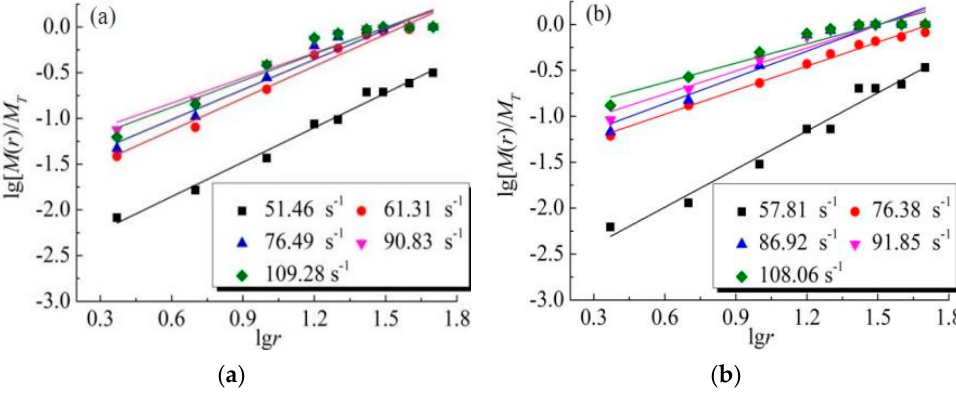
Figure 12. lg[ M ( r )/ M T ]-lg r linear fitting curve ( a ) PC; ( b ) CNFC02. The data points in Figure 12 show good linear correlation in the double logarithmic coordinate system, indicating that the distribution of concrete fragments after impact failure has fractal characteristics. This is because the microscopic cracks and pores in the concrete show self-similarity at different scales; besides, the breaking process and the shape of fragments are the direct results of crack propagation, thereby resulting in the power-law distribution of fragments, which is a fractal in the statistical sense. D b describes the distribution characteristics of the concrete fragment size after breaking. The larger D b is, the smaller the average particle size of the concrete fragments is, and the higher the degree of crushing of the specimen is. According to the analysis, the strain rate of the concrete under impact load. The relationship between the strain rate and D b is shown in Figure 13. It is found that there is no strict positive correlation between the strain rate and D b in this test. However, on the whole, the higher the strain rate level, the larger the value of D b . The test results can reflect the distribution characteristics of the particle size of the broken specimen to a certain extent. Moreover, in this paper, the same series of screening apertures (the same size) are used under different working conditions; therefore, the fractal dimension values obtained are comparable.